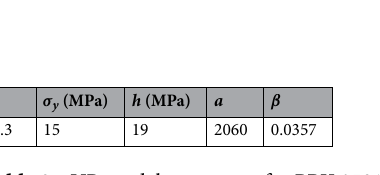
Table 3. VP model parameter for PBX